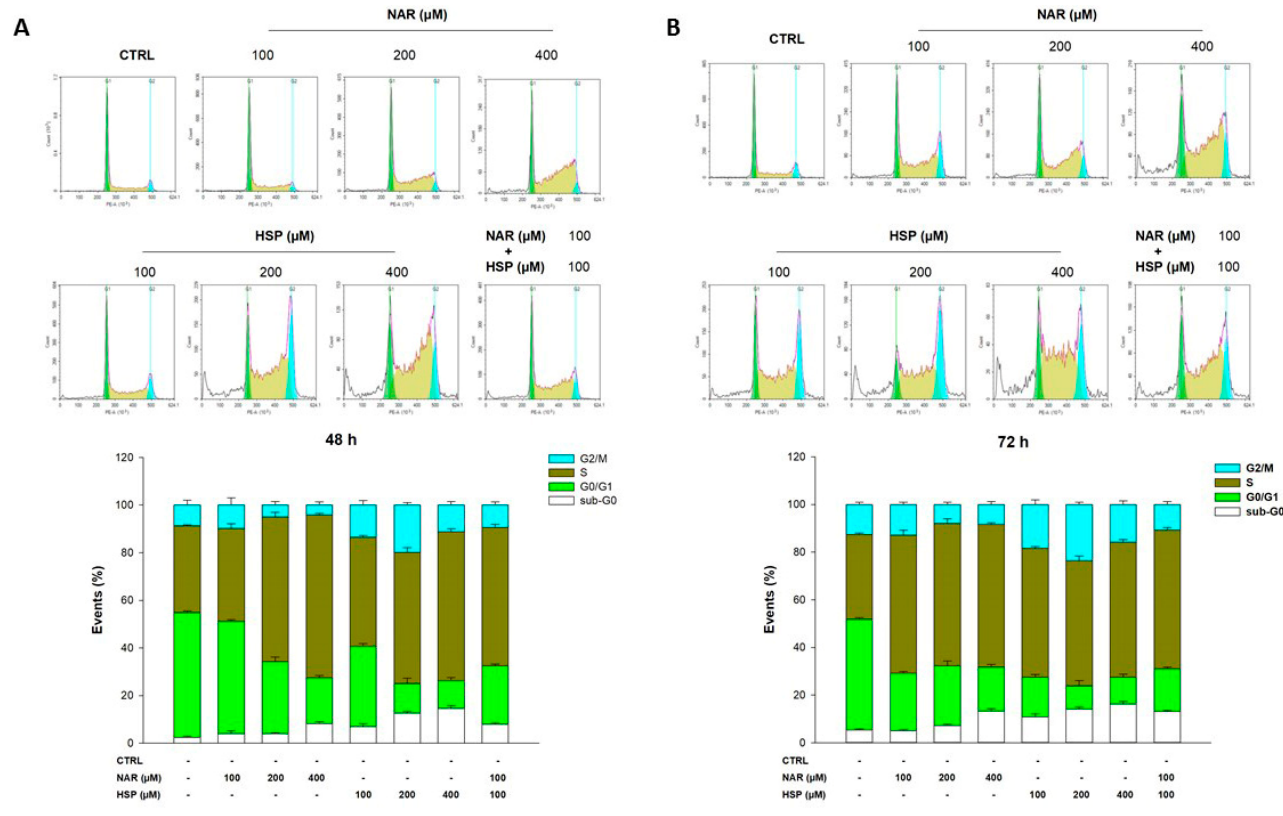
Figure 6. Influence of NAR and HSP, along with their combination, on THP-1 cell cycle progression after 48 h ( A ) and 72 h ( B ) of treatment. The plots are representative of three different experimental sessions of PI staining performed in triplicate ( n = 9). Percentages of cells present in each phase of the cell cycle are reported in the histograms (sub-G0/G1: white; G0/G1: green; S: yellow; G2/M: cyan).